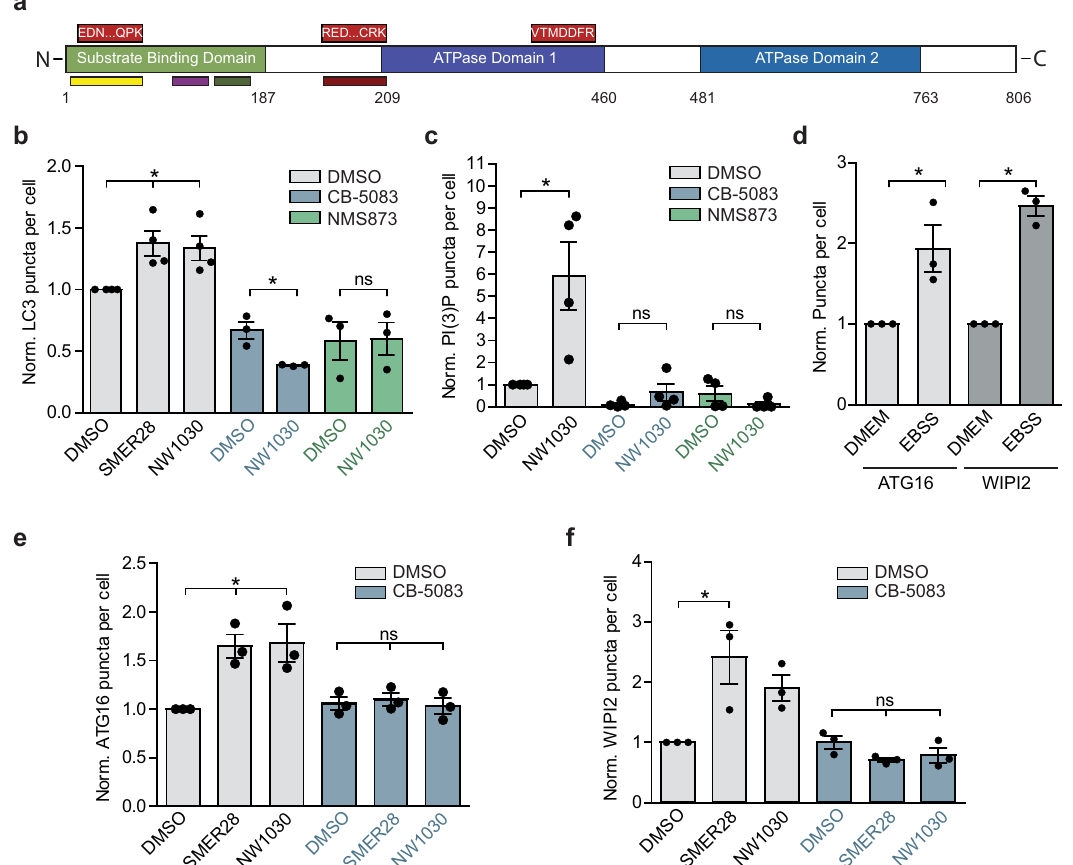
Fig. 4 SMER28 and NW1030 both induce autophagy by increasing PI(3)P production. a Linear representation of VCP protein with SMER28 binding peptides from Fig. 2 represented on top (red) and NW1030 binding peptides 47 indicated at the bottom (multicolor). b Number of LC3 puncta per cell normalized to DMSO control in cells treated with 20 μ M SMER28, 10 μ M NW1030 with or without 5 μ M CB-5083 or 10 μ M NMS873 for 8 h in presence of 400 nM BafA1, n = 4, representative images in Supplementary Fig. 4e; for SMER28 and NW1030 treatment alone: one-way ANOVA P = 0.0197 with post hoc Tukey test, NW1030 P = 0.0321, SMER28 P = 0.0191; for treatment in the presence of VCP inhibitors paired two-tailed Student ’ s t test. c PI(3)P puncta in cells treated with 10 μ M NW1030 with or without 5 μ M CB-5083 or 10 μ M NMS873 for 4 h; n = 4; paired Student ’ s t test, NW1030 P = 0.049; representative images in Supplementary Fig. 4f. d – f ATG16 and WIPI2 puncta formation in HeLa cells in basal (DMEM) and starvation (EBSS 2 h) in d or in cells treated with 20 μ M SMER28, 10 μ M NW1030 with or without 5 μ M CB-5083 for 4 h in e , f ; n = 3; representative images in Supplementary Fig. 4g; quanti fi cation in d (paired one-tailed Student ’ s t test, ATG16 P = 0.0429, WIPI2 P = 0.0037); quanti fi cation in e (for SMER28 and NW1030 treatment alone: one-way ANOVA P = 0.0189 with post hoc Tukey test, SMER28 P = 0.0248, NW1030 P = 0.0199; for treatment in the presence of VCP inhibitors: one-way ANOVA P = 0.788 (ns)); quanti fi cation in f (for SMER28 and NW1030 treatment alone: one-way ANOVA P = 0.0326 with post hoc Tukey